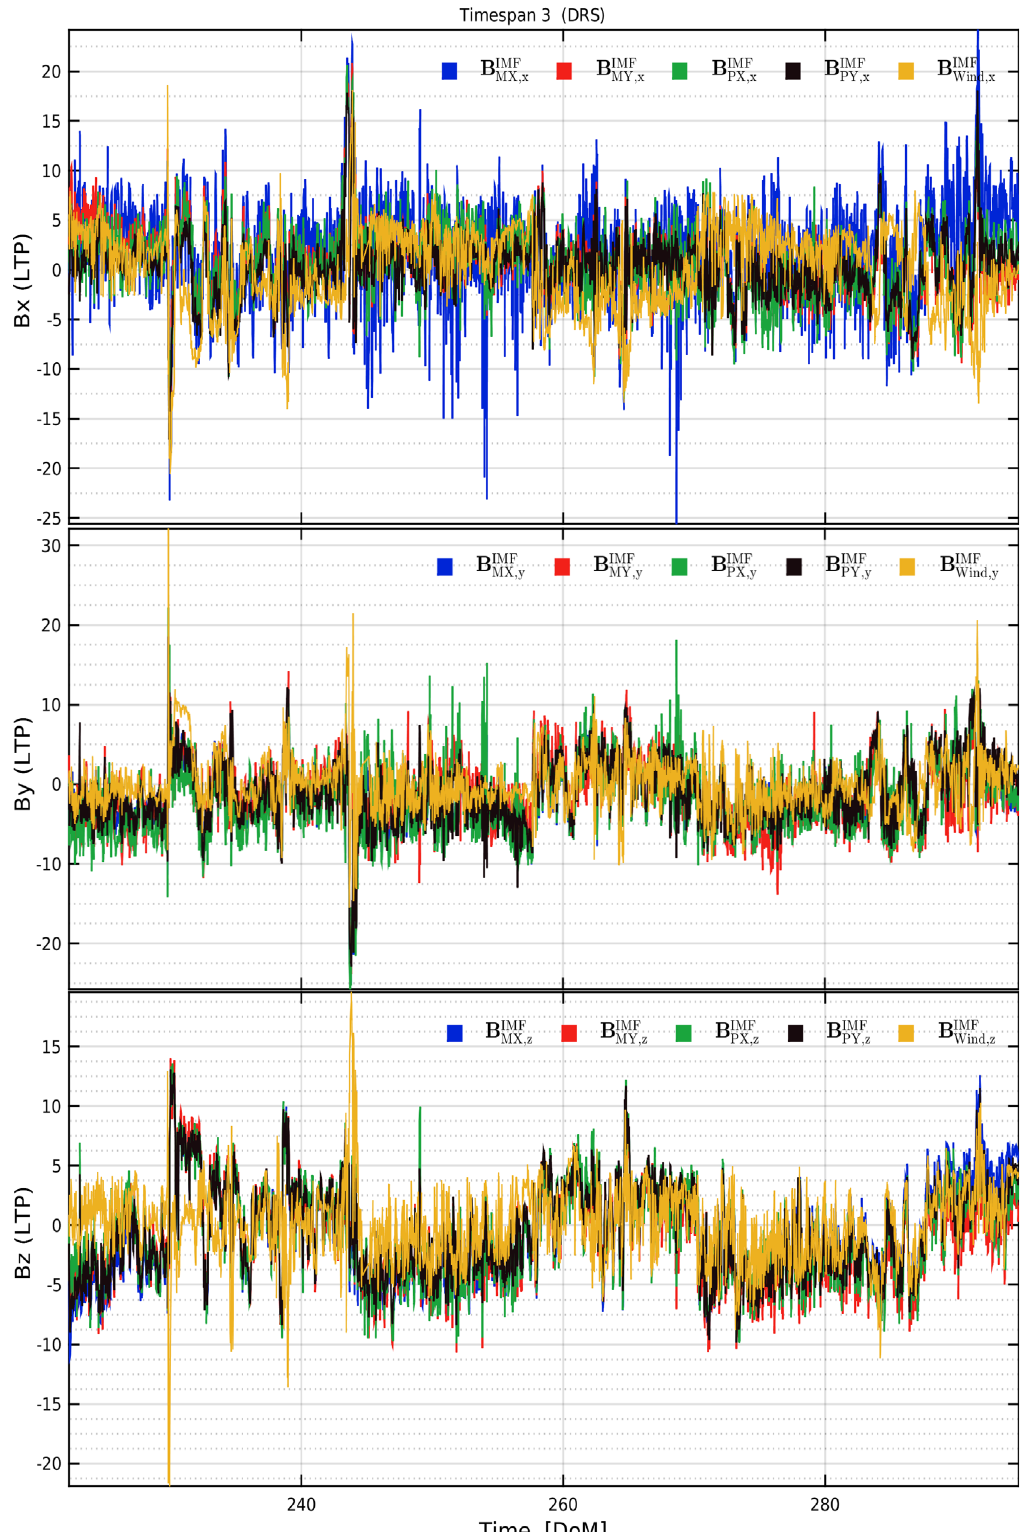
Figure 10. Same as Figure 9 for the TS3 time